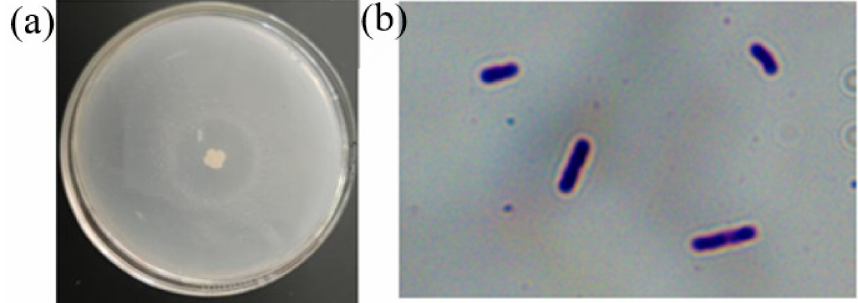
Figure 1. Colony morphology of strain Z-1 ( a ); Gram stain diagram of strain Z-1 ( b